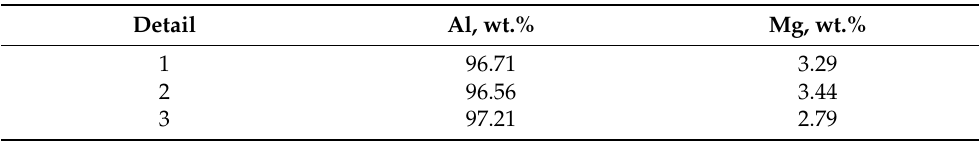
Figure 7. The microstructure of the sample in solution-hardened condition: ( a ) etched with Keller’s etching solution; ( b ) etched with Weck’s etching solution ; ( c ) SEI with indicated details for EDS analysis. Table 5. The results of the EDS analysis of the solution-hardened sample performed on the details indicated in Figure 7c.